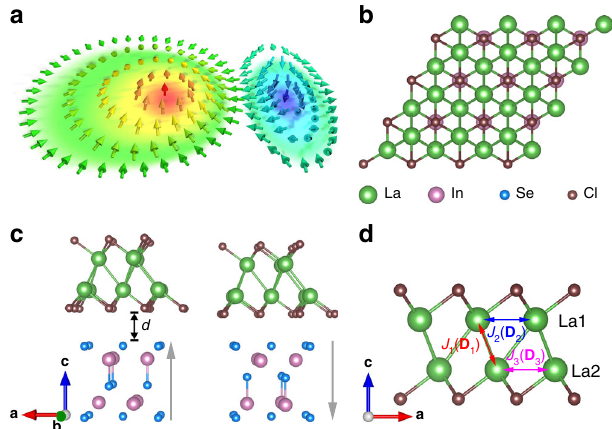
Fig. 1 Crystal structure diagram of LaCl/In 2 Se 3 HS. a Illustrations of a magnetic bimeron. b , c show the top and side views of the HS, respectively. The gray arrow represents the polarization direction of In 2 Se 3 . d Magnetic structure of LaCl for calculating the exchange coupling parameter (DMI